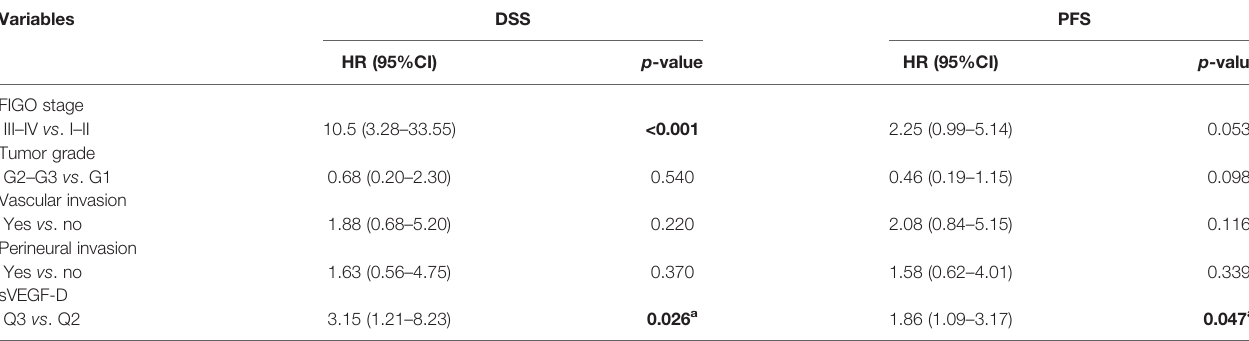
TABLE 3 | Multivariable survival analysis for both disease-speci fi c survival (DSS) and progression-free survival (PFS) on 61 VSCC patients from cohort A.